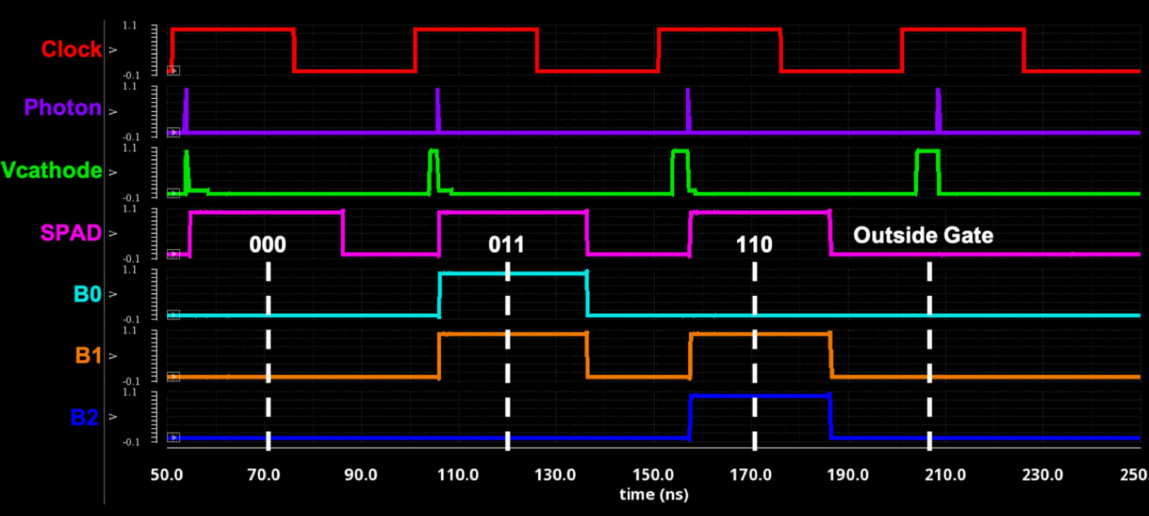
Figure 8. Sample of the post-layout transient simulation